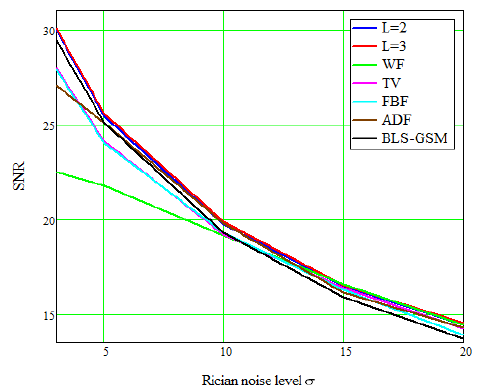
Figure 3. Comparison of measurements SNR of methods with different Rician noise levels